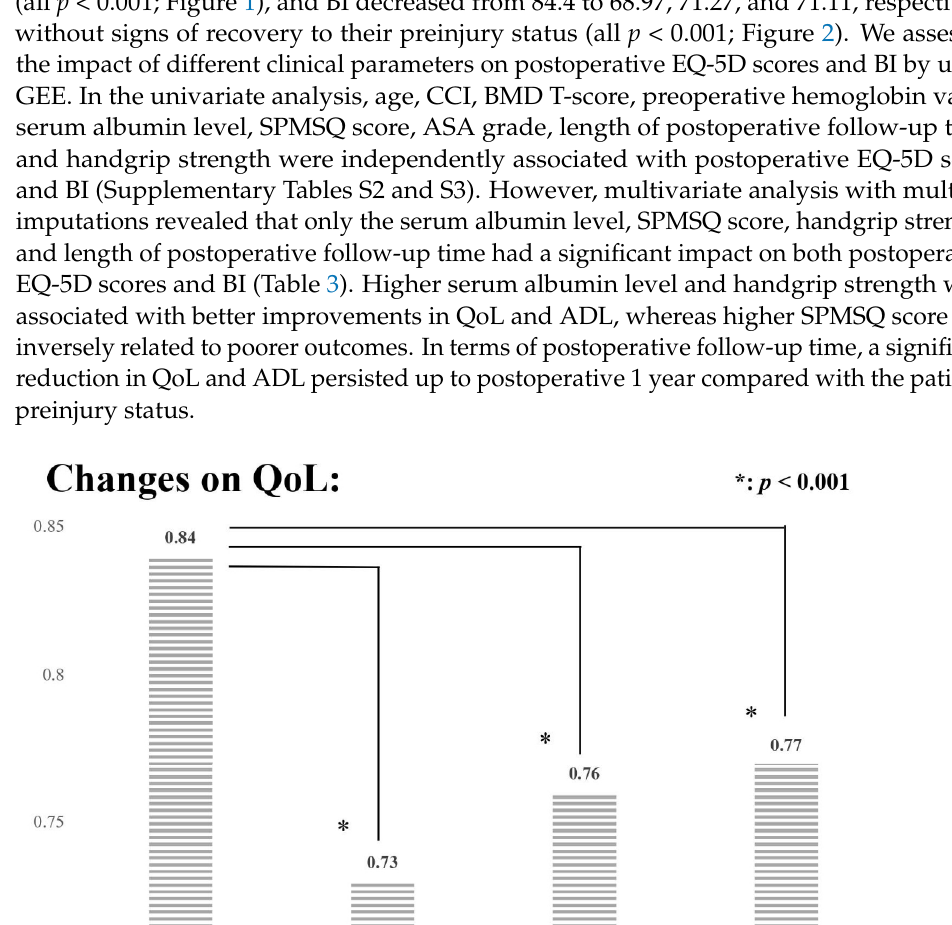
Figure 2. Consecutive ADL (BI) measurements at preinjury, 3, 6, and 12 months after hip fracture repair surgery. *: p < 0.001.